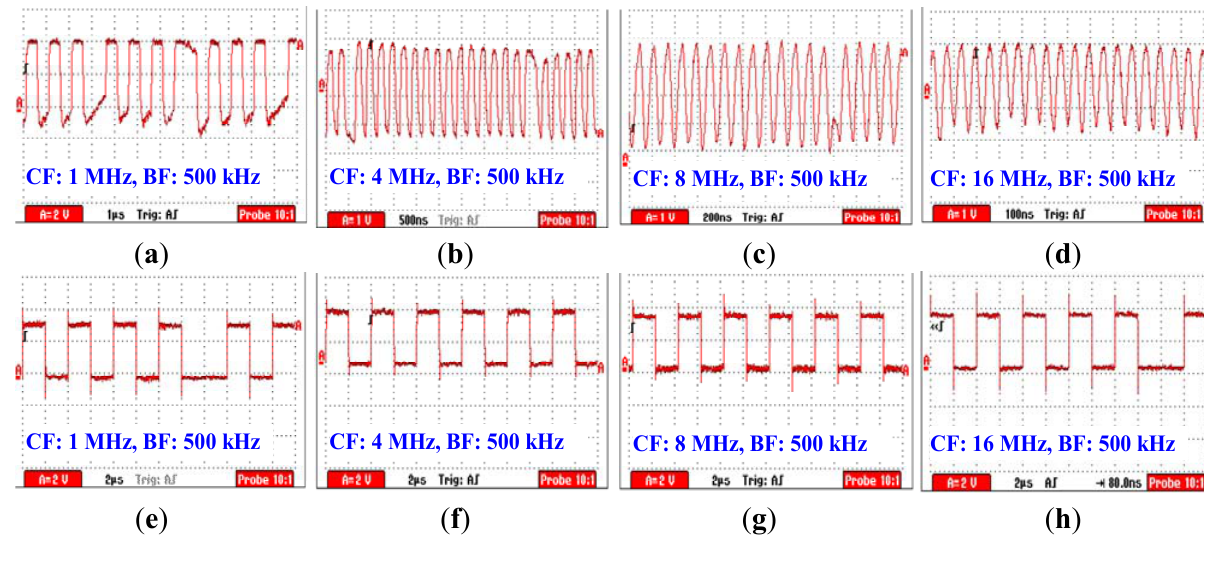
Figure 8. The modulated signal received by the Mach-Zehnder EO sensor on conditions that BF = 500 kHz and CF is ( a ) 1 MHz, ( b ) 4 MHz, ( c ) 8 MHz and ( d ) 16 MHz, respectively. Figure ( e , f , g , h ) are the corresponding demodulated signals of the modulated signals shown in Figure ( a , b , c , d ),